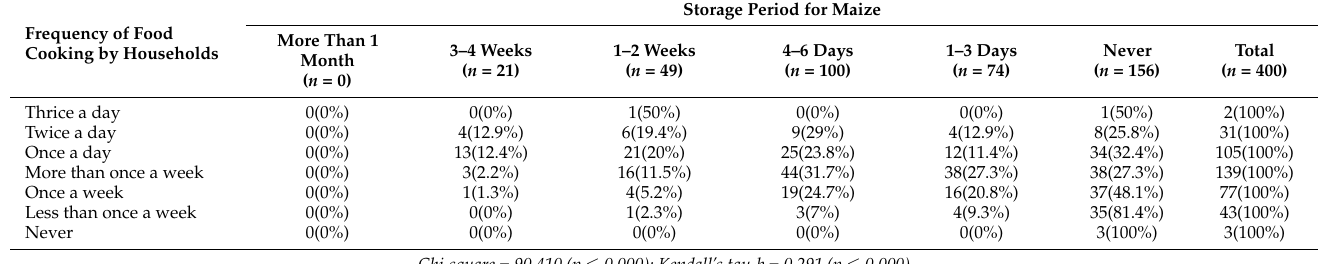
Table 6. Relationship between frequency of food cooking by households and storage of maize and